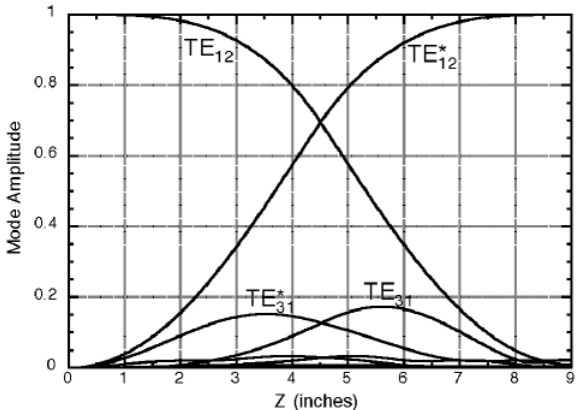
FIG. 21. Calculated mode amplitude profiles along the polar- ization converter, or mode rotator, for an entering TE 12 wave. The asterisks here indicate cross-polarized